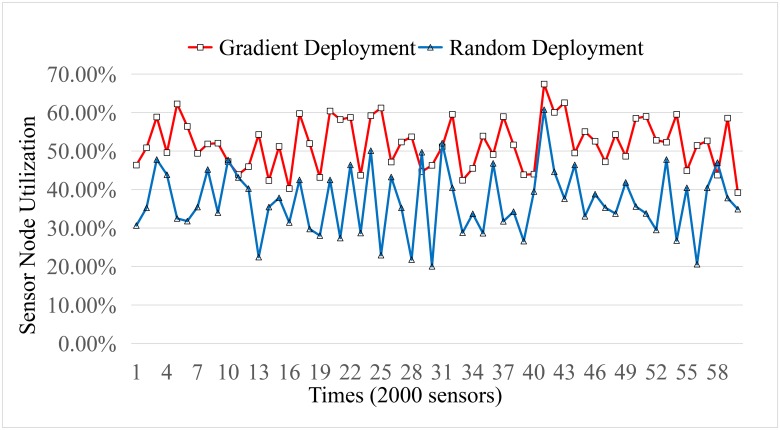
Sensor utilization.